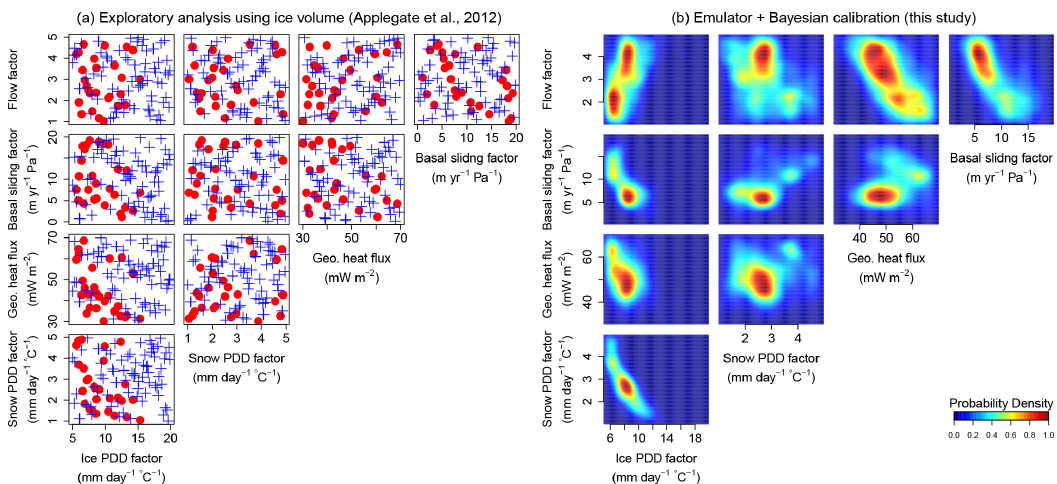
Figure 4. Comparison between an exploratory data analysis, following Applegate et al. (2012), and the results of our probabilistic calibration. Scatterplots of parameter settings used to train the emulator, as projected onto two-dimensional marginal spaces (a) . Red dots are parameter settings resulting in simulated modern ice volumes within 10% of the synthetic truth (model run #67 of Applegate et al., 2012); blue crosses are parameter settings that yield ice volumes more than 10% larger or smaller than the synthetic truth. Two-dimensional marginal posterior densities of all pairs of input parameters (b) . Several of the marginal posterior density maps show inclined bands of higher probability, indicating interactions among parameters; other panels show multiple modes, representing potential “traps” for tuning of ice sheet models using simpler methods. See text for